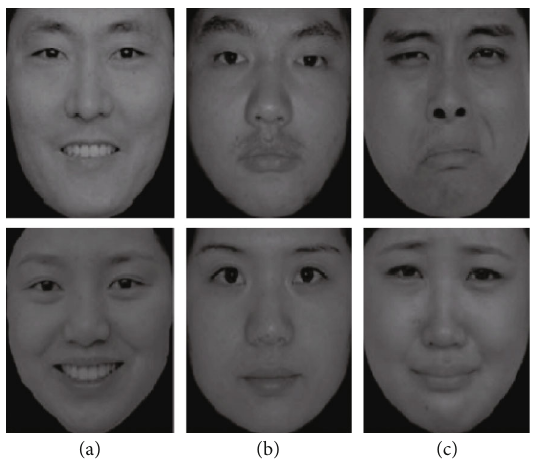
Figure 1: Example of the happy (a), neutral (b), and sad (c) faces used in the